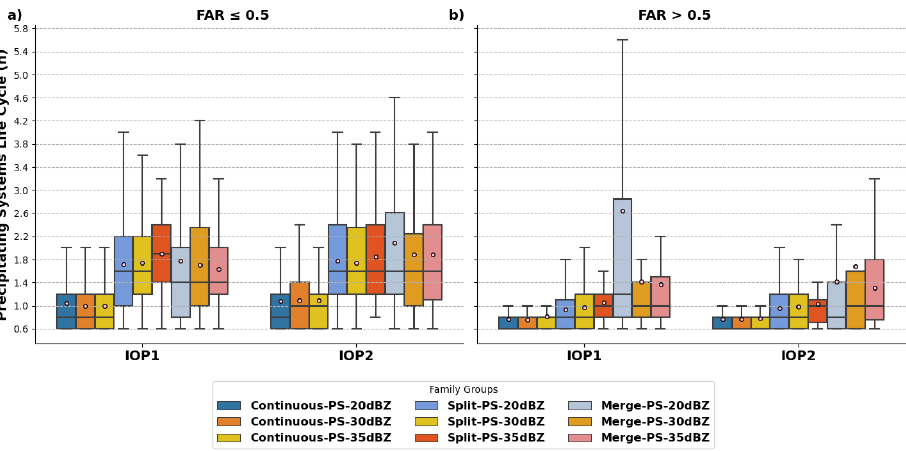
Figure 13. Life cycle (hour) boxplots for each precipitating system class by continuous, split, and merges at each IOP and identification threshold, divided into: ( a ) FAR ( ≤ 0.5) and ( b ) FAR > 0.5. The circles within each boxplot represent the mean value.